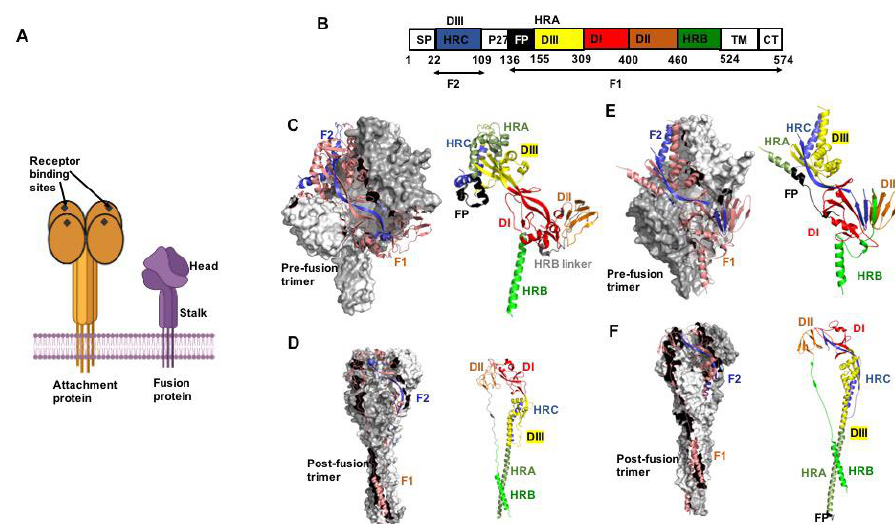
Figure 1. The pneumo- and paramyxovirus entry machinery. ( A ) Schematic of paramyxovirus attachment and F proteins showing the overall head and stalk organization of the attachment protein tetramer and F protein trimer, respectively. ( B ) Color-coded schematic representation of the F protein domain organization (shown by example of RSV F). Heptad repeat (HR) domains A (HRA) and B (HRB) form the post- and prefusion F helical stalks, respectively. HR domain C (HRC) is located in the membrane-distal section of the prefusion F head. SP, signal peptide; FP, fusion peptide; TM, transmembrane domain; CT, cytoplasmic tail. The precursor F 0 precursor protein is cleaved into F 1 and F 2 subunits. ( C ) Crystal structure of the prefusion PIV5 F trimer (PDB 4GIP). Surface view with one monomer shown as cartoon (left panel). F 2 in blue and F 1 in salmon. Domain view of a single monomer (right panel), colored as in (B). ( D ) Postfusion hPIV3 F trimer (PDB 1ZTM), the 6HB is oriented towards the base of the structure. ( E , F ) Pre- and postfusion forms of RSV F (PDB 4MMQ and 3RRR, respectively). Subtle di ff erences in overall geometry to paramyxovirus F are present in the prefusion head specifically. All figures were prepared with PyMol (DeLano Scientific; http: // pymol.sourceforge.net /